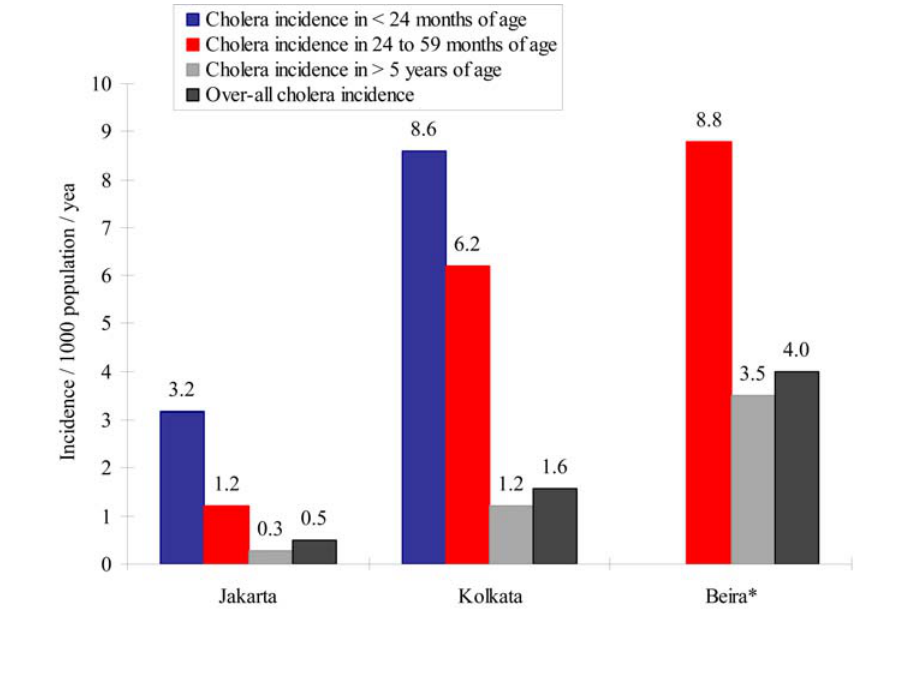
Figure 1. Cholera incidence (per 1000 population per year) in study sites in three countries.